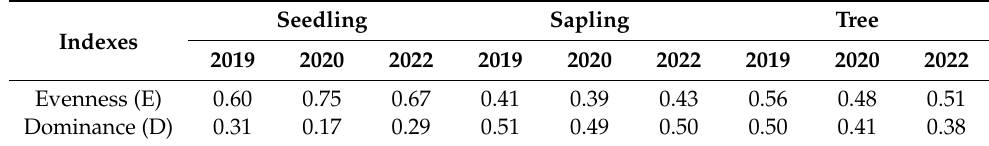
Table 9. Index of evenness and dominance of vegetation planting with propagules.